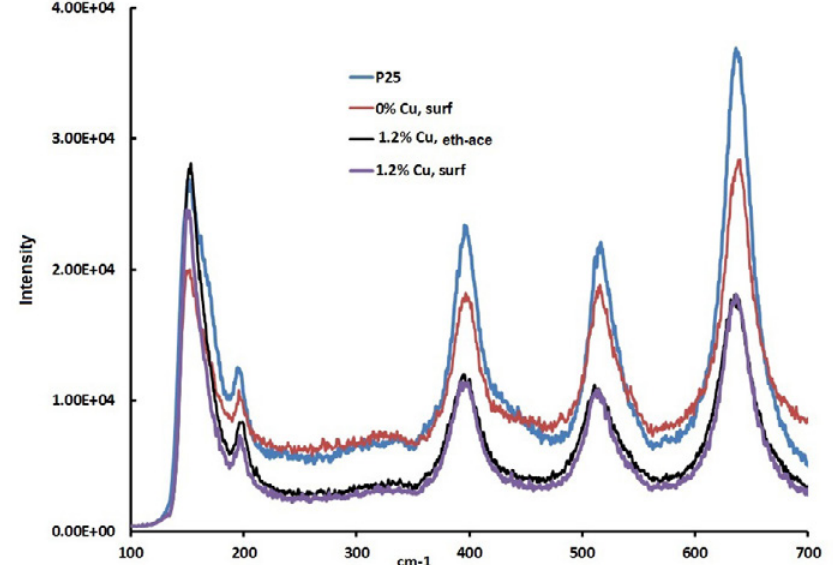
Fig. 3. Raman spectra of the samples prepared in two different Fig. 3 Raman spectra of the samples prepared in two different media.